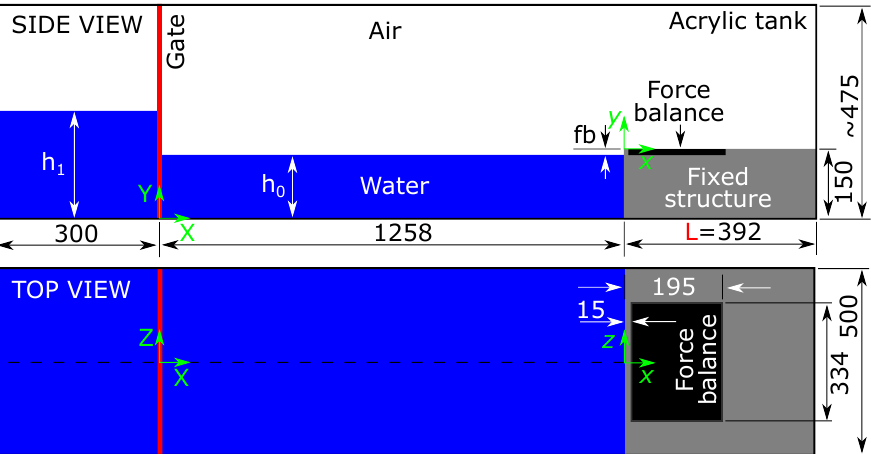
Figure 1. Sketch of the wet dam-break setup used to generate isolated shipping water events on a fixed structure. A force balance was fixed in the surface of the structure to measure the vertical loads of the shipping water. Adapted from [14]. Dimensions in